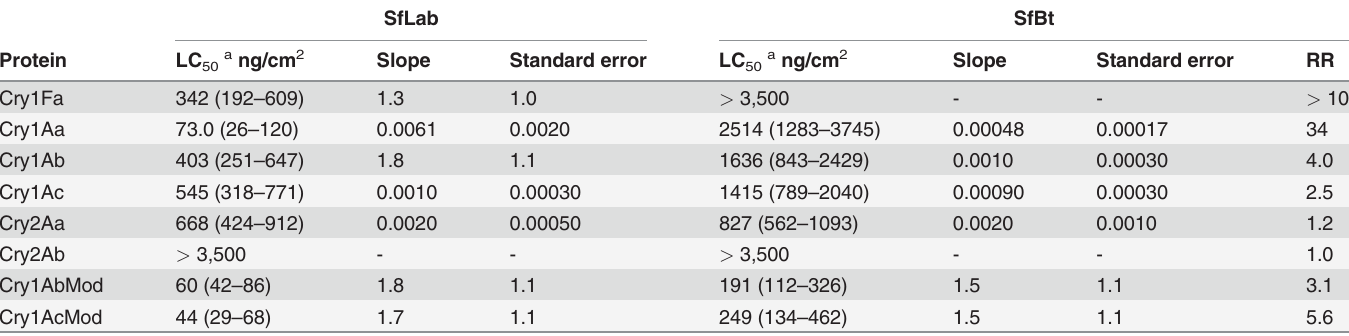
Table 1. Toxicity of different Cry toxins to S . frugiperda colonies of SfLab and SfBt. SfLab SfBt Protein